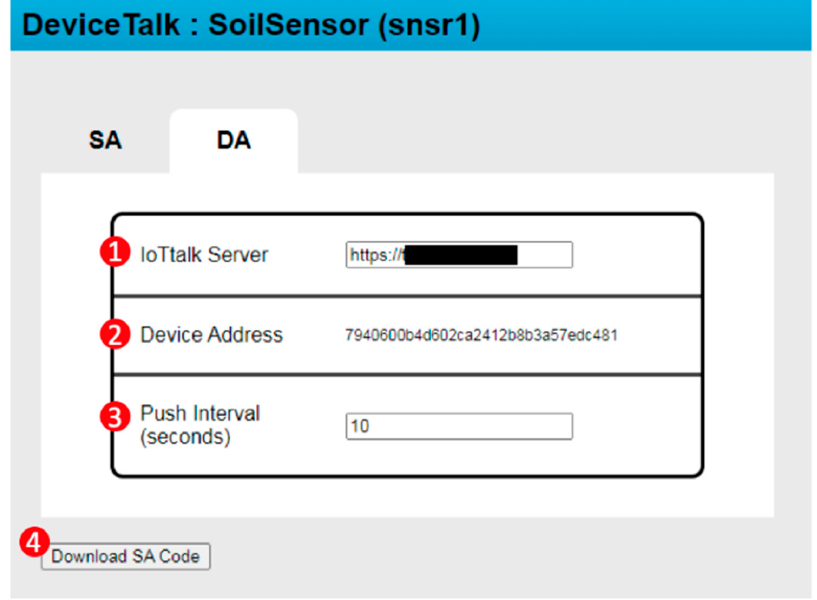
Figure 8. The DA